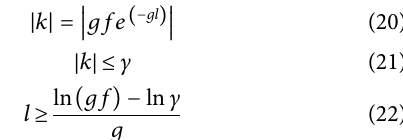
Frontiers in Earth Science |